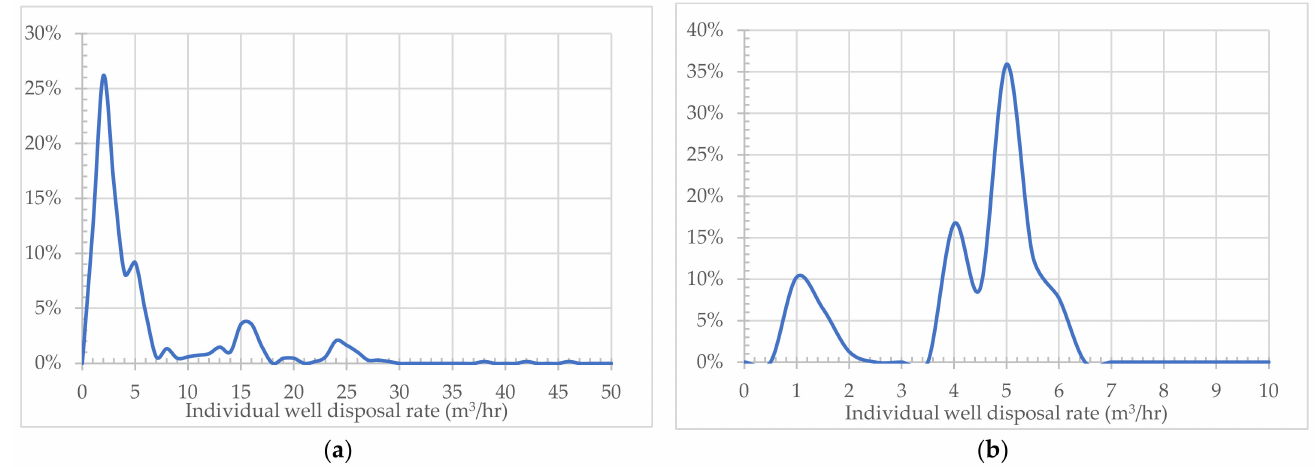
Figure A19. Historical per-well water injection rate ( X -axis) frequency ( Y -axis) distributions (January 1962–December 2022) in ( a ) the Halfway Formation; ( b ) the Doig Formation.